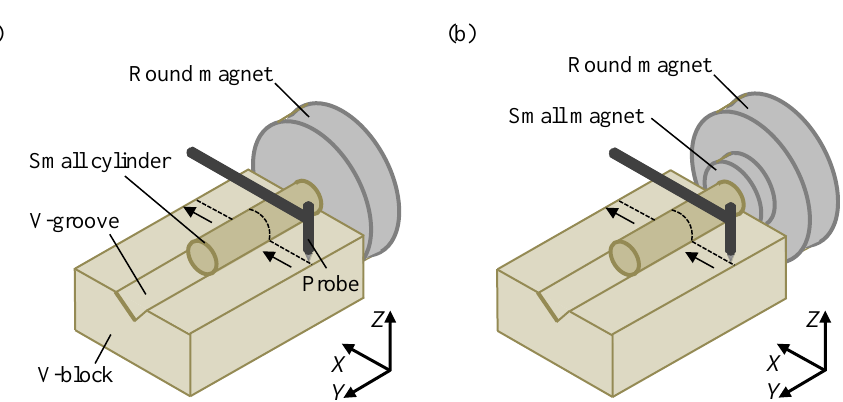
Figure 13. A schematic of the workpiece-holding mechanism: ( a ) Before modification; ( b ) After modification.